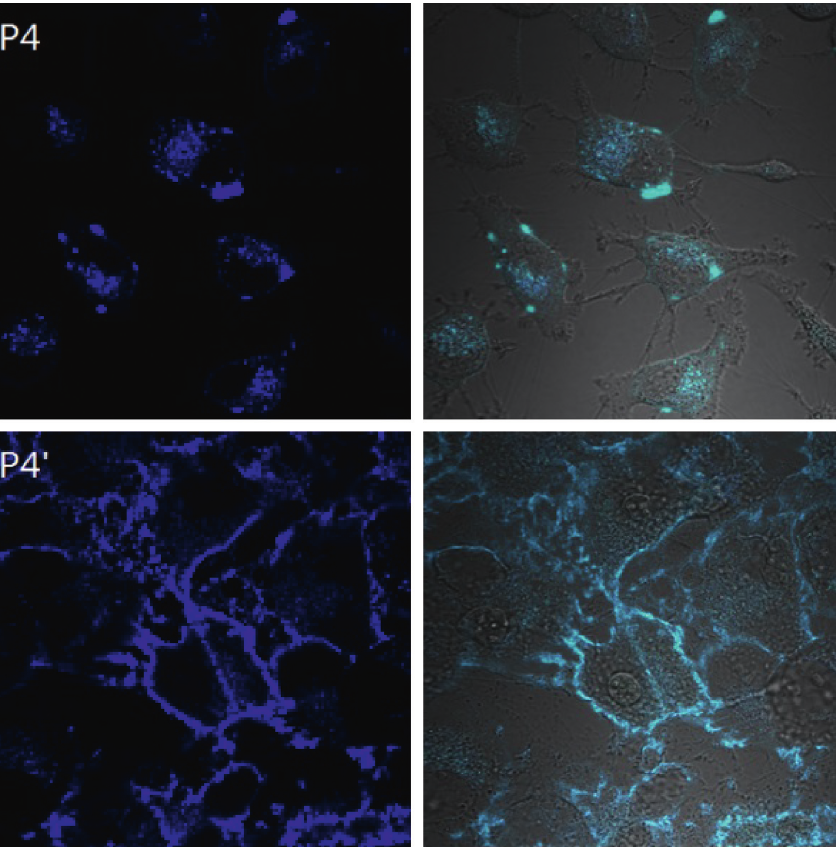
Figure 14: CLSM fluorescence and fluorescence/transmission overlapped images of A498 cells treated with 0.1mg/mL polymer for 2h. The signals are collected above 420nm upon excitation at 380nm for both P4 and P4 ′